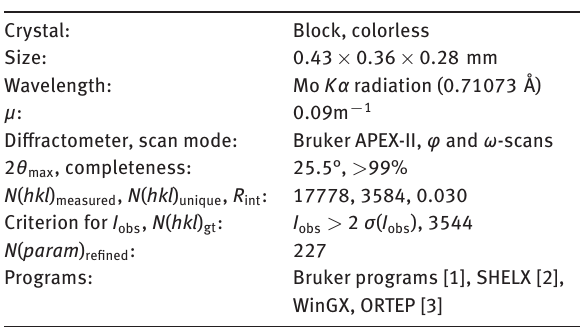
Table 1: Data collection and handling.